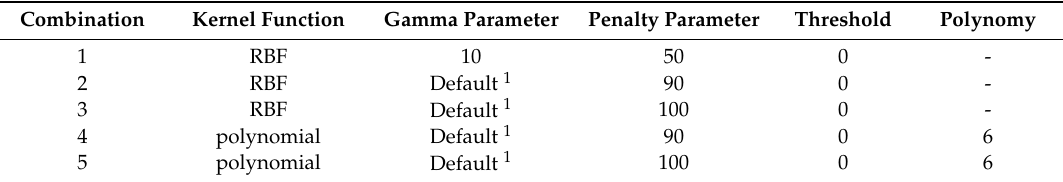
Table 3. Applied support vector machine (SVM) parameters for Landsat 8 (L8) and WorldView-2 (WV2) images.